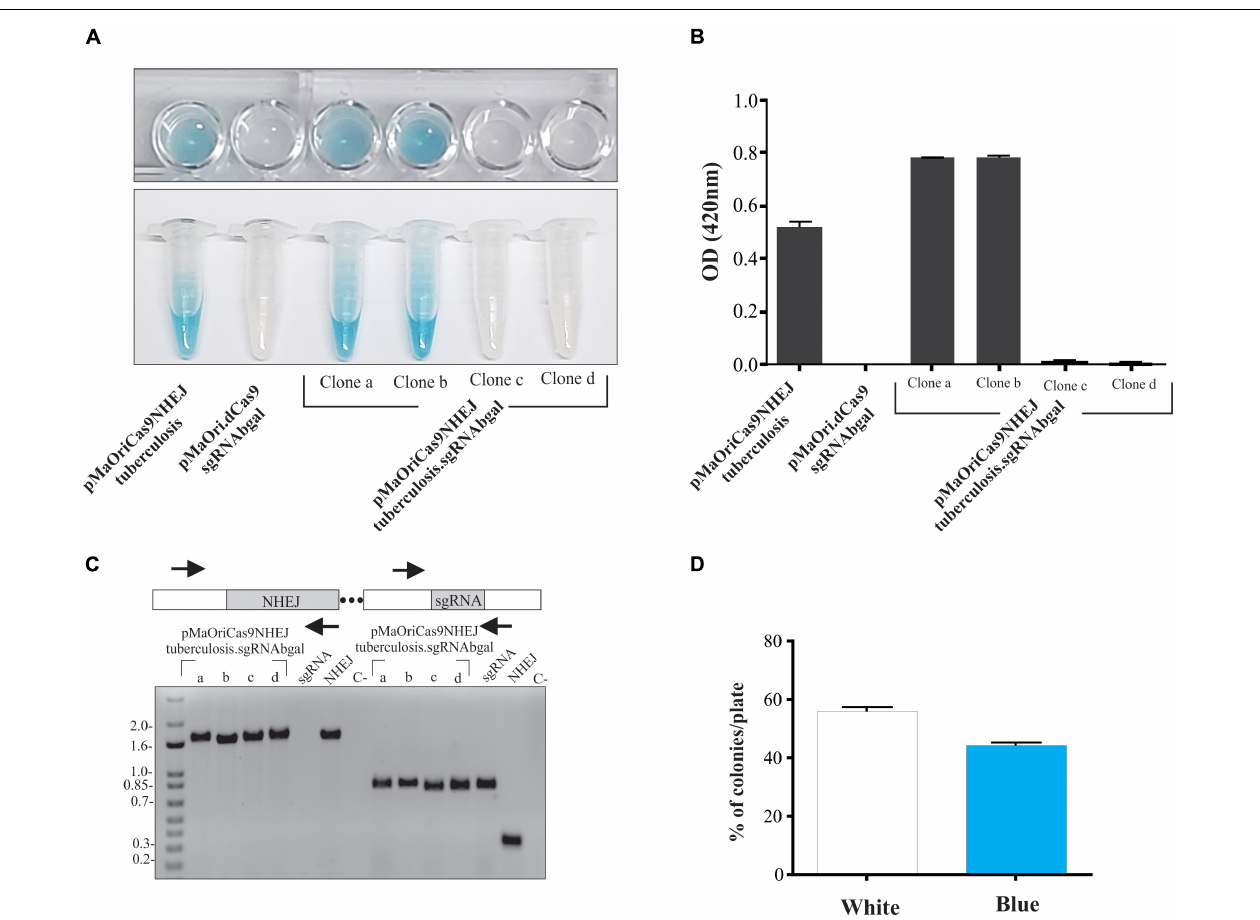
FIGURE 2 | Evaluation of β -galactosidase activity in recovered recombinant L. biflexa . Grown cultures from individually selected colonies from pMaOriCas9NHEJtuberculosis (positive control), pMaOri.dCas9sgRNAbgal (negative control), and pMaOriCas9NHEJtuberculosis.sgRNAbgal (clones “a” to “d”) were accessed for β -galactosidase activity by X-gal (A) and ONPG (B) chromogenic substrate. Cultures were also validated by PCR with primers targeting the NHEJ and sgRNA cassette (C) . Plasmids pMaOri.dCas9sgRNAbgal (positive for sgRNA, no NHEJ cassette), pMaOriCas9NHEJtuberculosis (positive for NHEJ cassette, no sgRNA), and negative control (C-) with no DNA template were included. (D) X-gal sterile solution was spread onto plates with pMaOriCas9NHEJtuberculosis.sgRNAbgal-containing colonies for accessing the white/blue